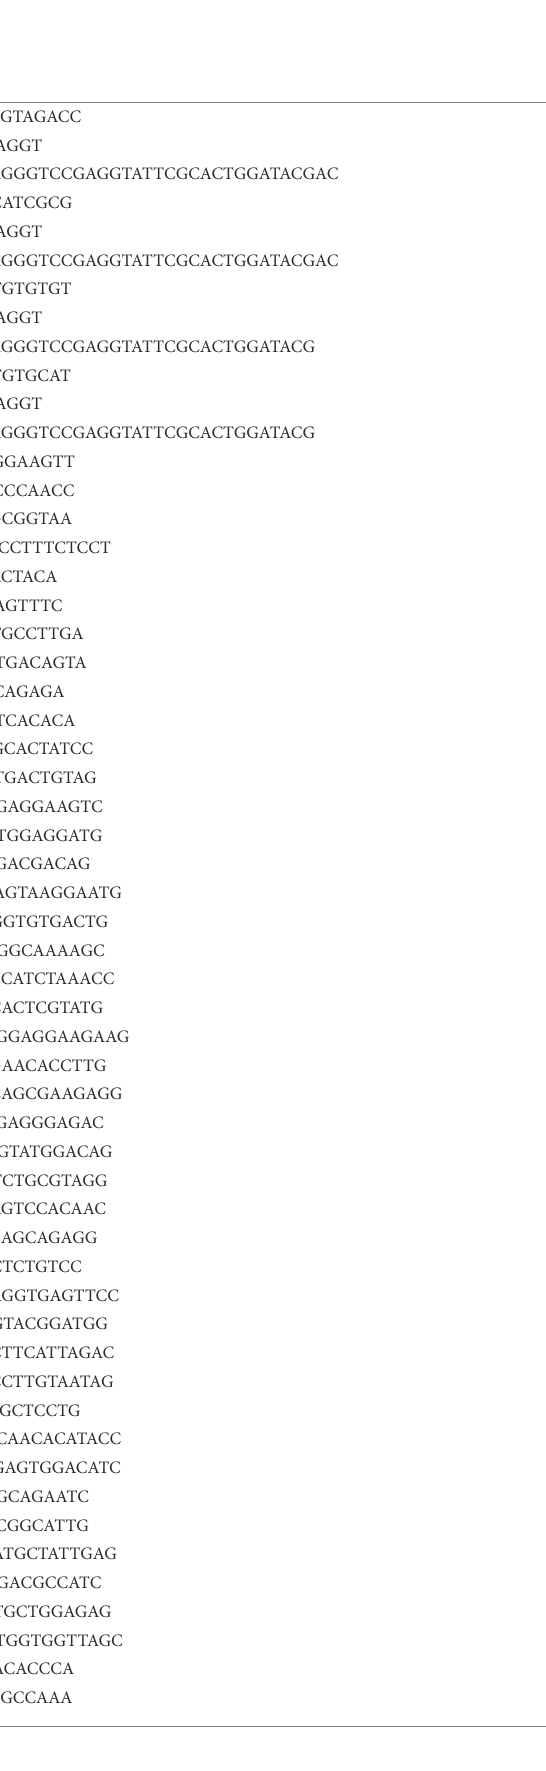
TABLE 1 Primer sequences of the RNAs in the present